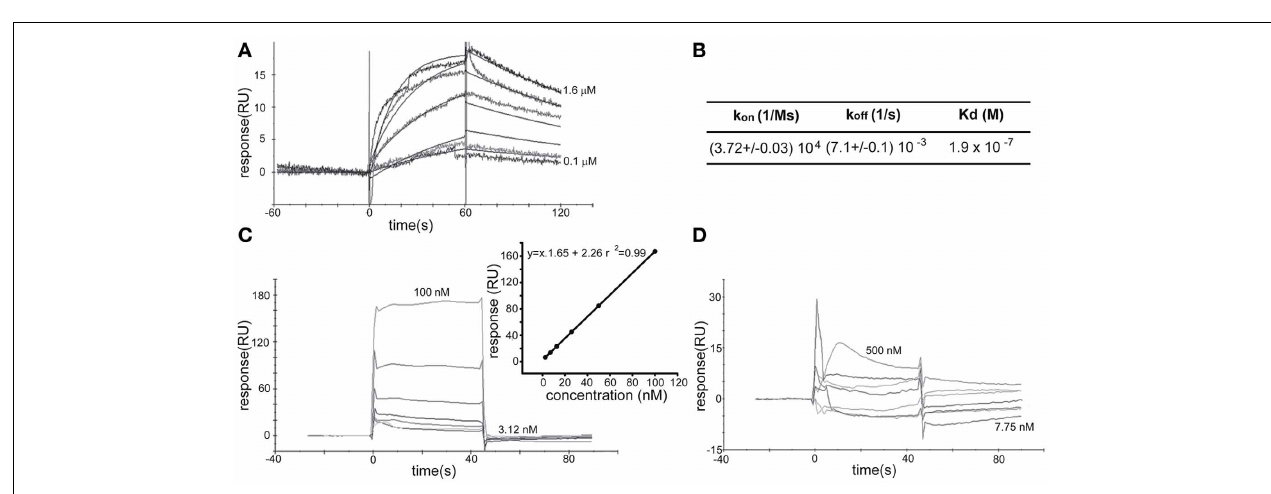
Wnt3a, immunoprecipitated with anti-Wnt3a and probed with (B) β gc antibody to reveal IGF-1r; (C) anti-Ror2; and (D) anti-TrkB (BDNF receptor prominent at the growth cone of developing neurons) Immunoprecipitation of Wnt3a is shown to confirm successful IP and as a loading control. IP, immunoprecipitate; S, soluble fraction after immunoprecipitation. All blots are representative of at least three independent experiments.